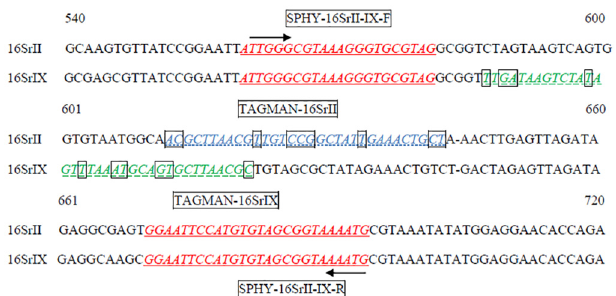
Fig 1. Sequence alignment of the 16S ribosomal gene region used for amplification and specific detection of sesame 16Sr group II and IX phytoplasmas. Sequences of the primers and probes designed in this study are shown in underlined and italic letters, respectively. Forward primer SPHY-16SrII-IX-F (upper arrow, red), probe 16SrII (dotted line, blue) and 16SrIX (solid line, green), and reverse primer SPHY- 16SrII-IX-R (lower arrow, red) are noted. The sequence differences between 16SrII and 16SrIX in the probe regions were shown in boxed